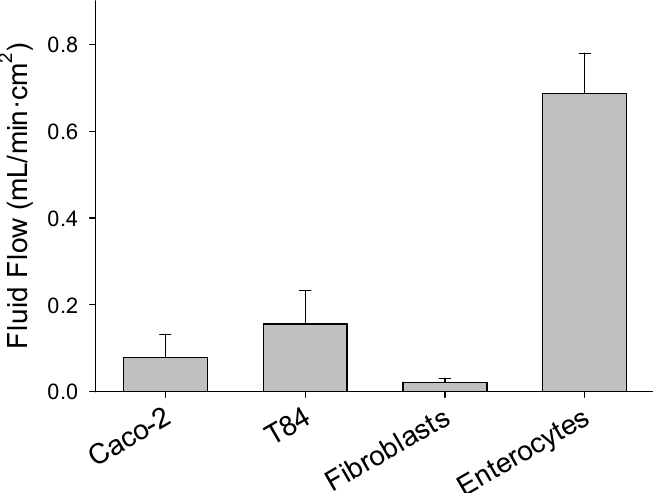
Figure 6. The rate of fluid flow was measured by epithelia prepared with Caco-2, T84 cells, fibroblasts, and harvested enterocytes that were cultured on 12 µm insert and exposed to vigorous aeration for 5 min.